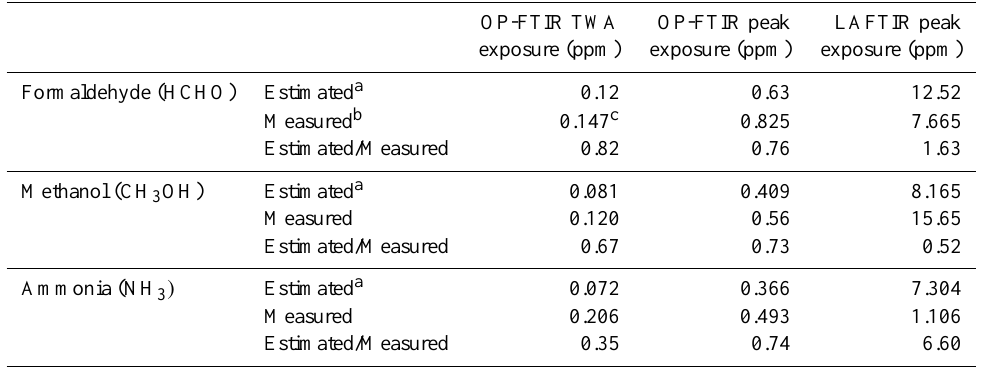
Table A2. Estimated and measured exposures for species measured both by the OP-FTIR and in Yokelson et al. (2013) reported as excess mixing ratios (see Sect. 3.5 for